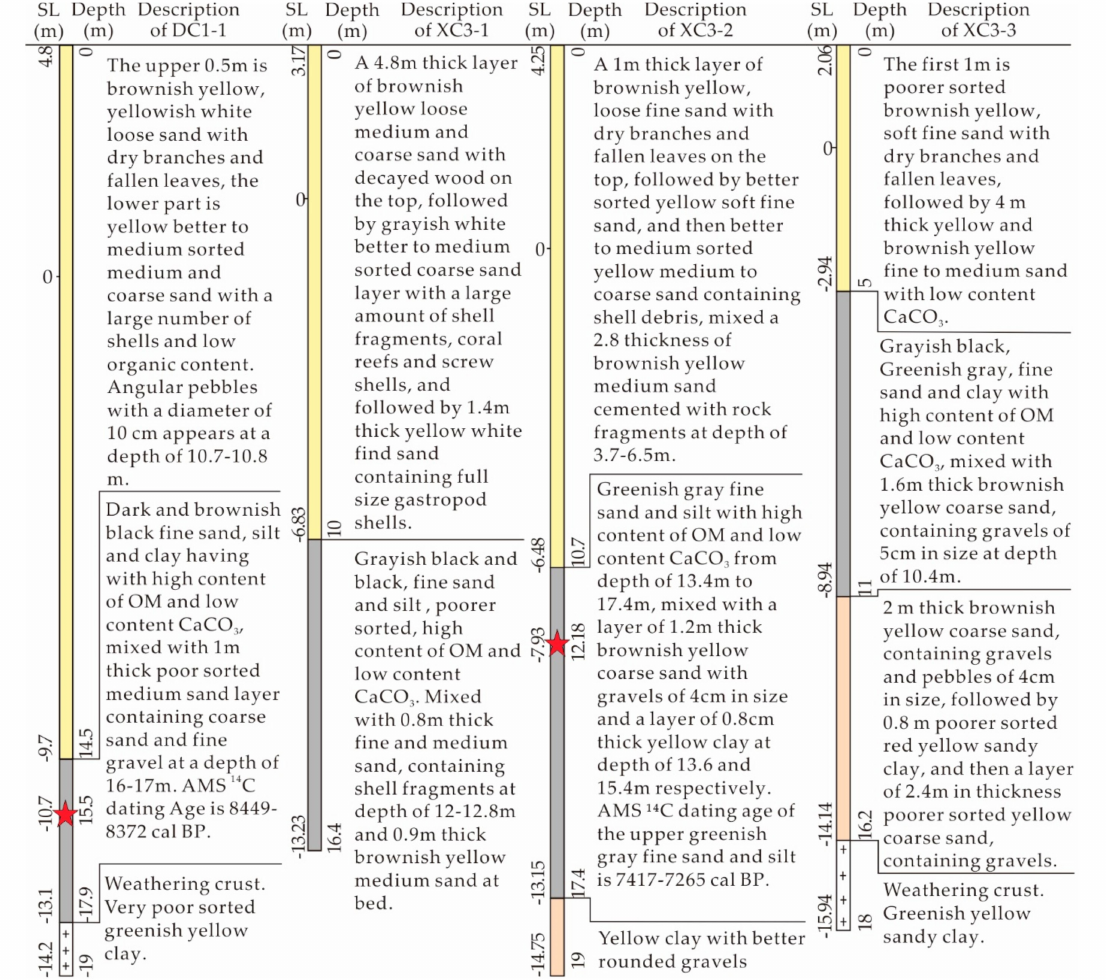
Figure 3. The description of strata profiles in Xichong Bay and Dongchong Bay. Red star